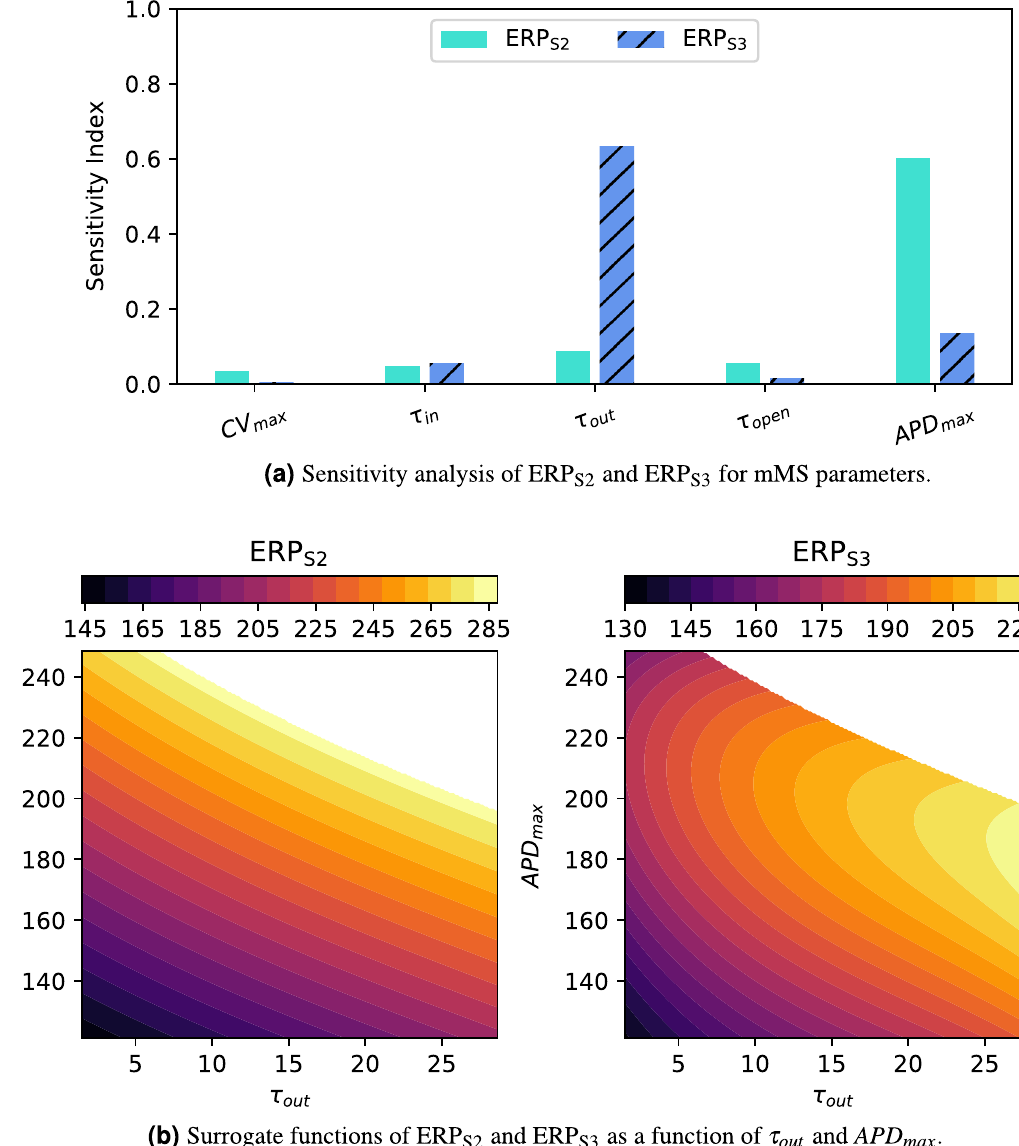
Figure 2. ( a ) Sensitivity analysis of ERP for the mMS electrophysiology model for all parameters. τ out and APD max have the largest sensitivity indices for both types of ERP. ( b ) Surrogate functions for predicting ERP 285 ms, so this region is shown in from τ out and APD max . A discontinuity in ERP S3 occurs at ERP S2 ≈ used to calibrate EP parameters sufficiently to reproduce not only these ERP measurements, but also the time required for the action potential to reach various levels of repolarization recovery (e.g. APD 20 and APD 90 , the time required for 20% and 90% recovery). It is a key finding that the S1S2S3 protocol can be used (alongside the standard S1S2 protocol) to disentangle the contributions of separate parts of the action potential to the value of ERP, without needing to measure the action potential directly. The sensitivity indices in Fig. 2a show that these ERP measurements are mainly determined by τ out and APD max , which approximately correspond to the duration of the repolarization and plateau phases of the action potential respectively. Calibration of other parameters, which determine some aspects of the shape of restitution curves but which do not strongly impact ERP, require both CV and APD restitution curve data from an S1S2 τ out and θ 2 APD max . Figure 2b protocol 21 . For this reason, we have determined to use ERP to calibrate θ 1 ≡ ≡ shows contour plots of the surrogate functions for ERP. A discontinuity occurs in the ERP S3 surface for param- eters combinations resulting in ERP S2 > 285 ms, so data for ERP S2 > 280 ms were discarded before fitting this function. Note that the majority of clinical ERP S2 measurements fall in the range 170–270 ms, so even 280 ms could be considered as an upper limit 29 .